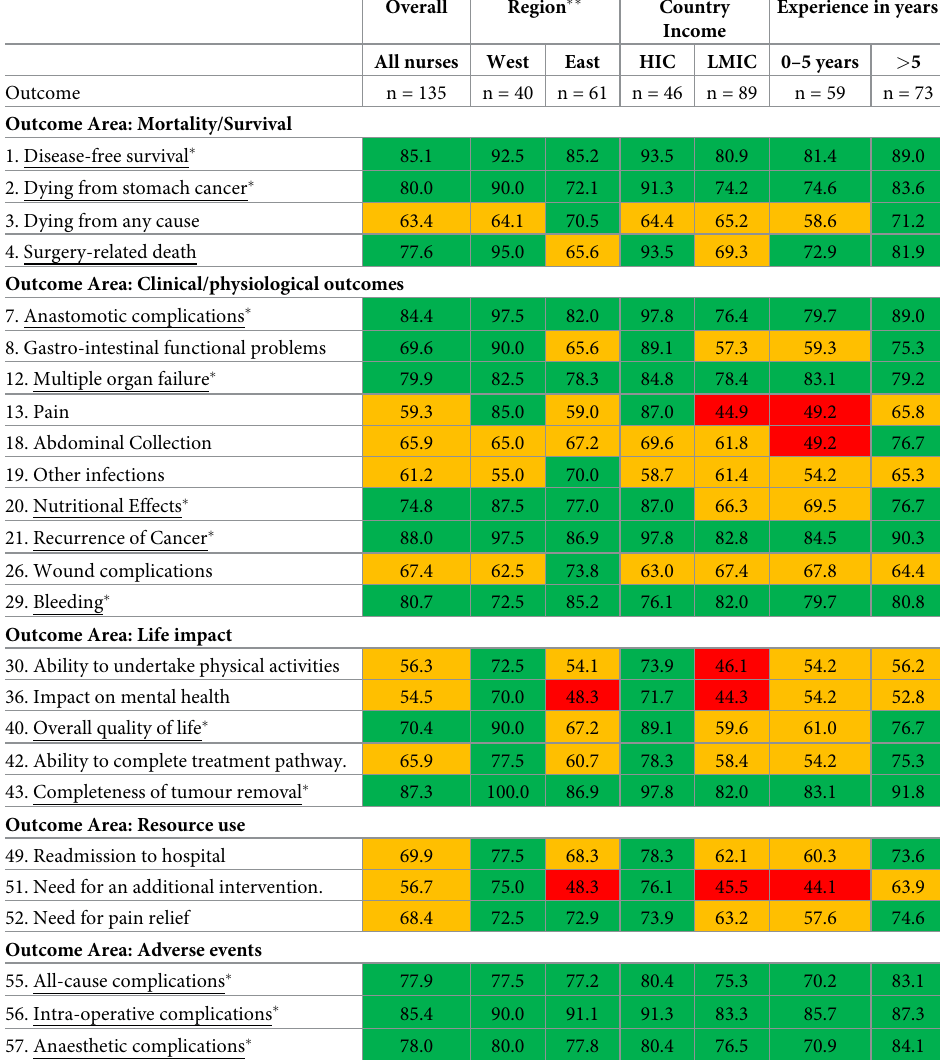
Values are the percentage of participants voting the outcome as critically important (score 7–9). Green = for inclusion, Red = for exclusion, Yellow = no consensus. HIC = high income country, LMIC = low- to middle-income country; � Denotes outcomes are those which were included in the final list of outcomes for automatic inclusion in the COS. �� Participants not from either Western or Eastern countries were excluded from this